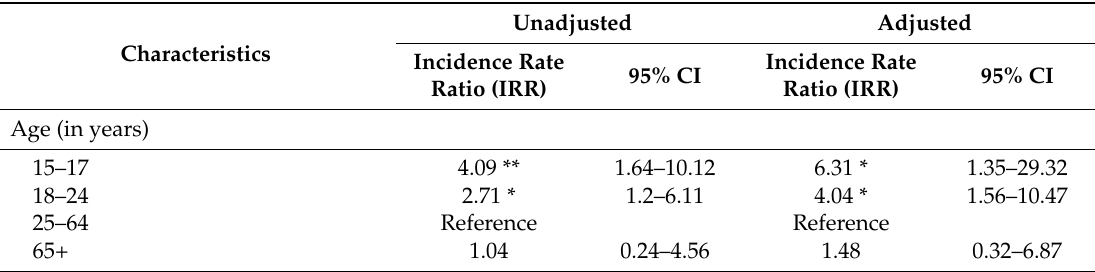
Table 4. Unadjusted and adjusted analysis for fatal suicidal behavior by socio-demographic and geographical factors, rural